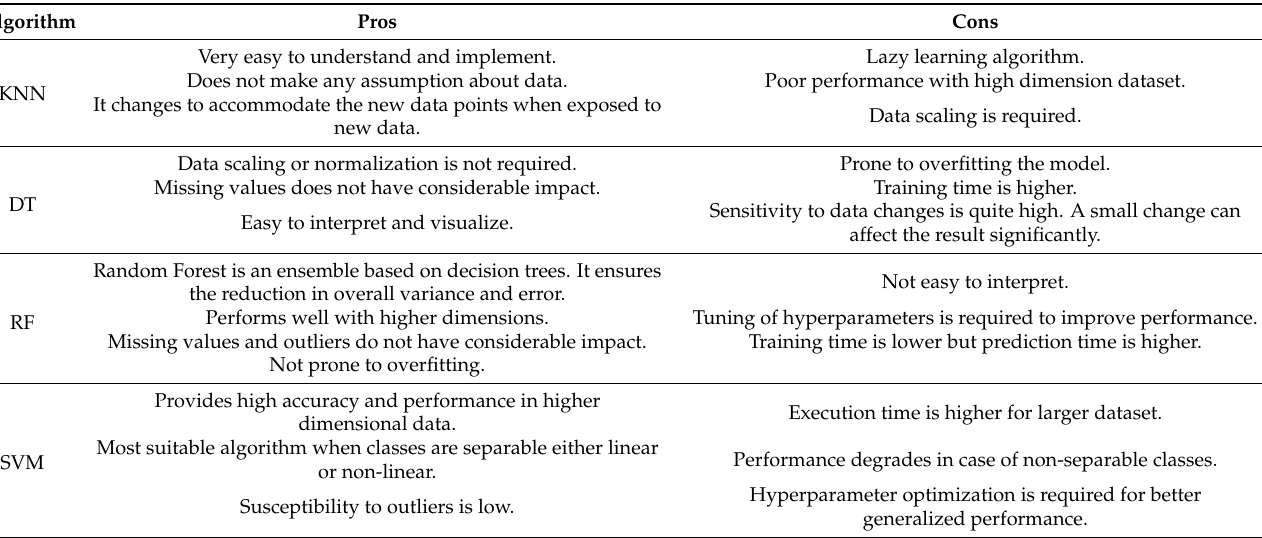
Table 2. Pros and Cons summary of Proposed Classification